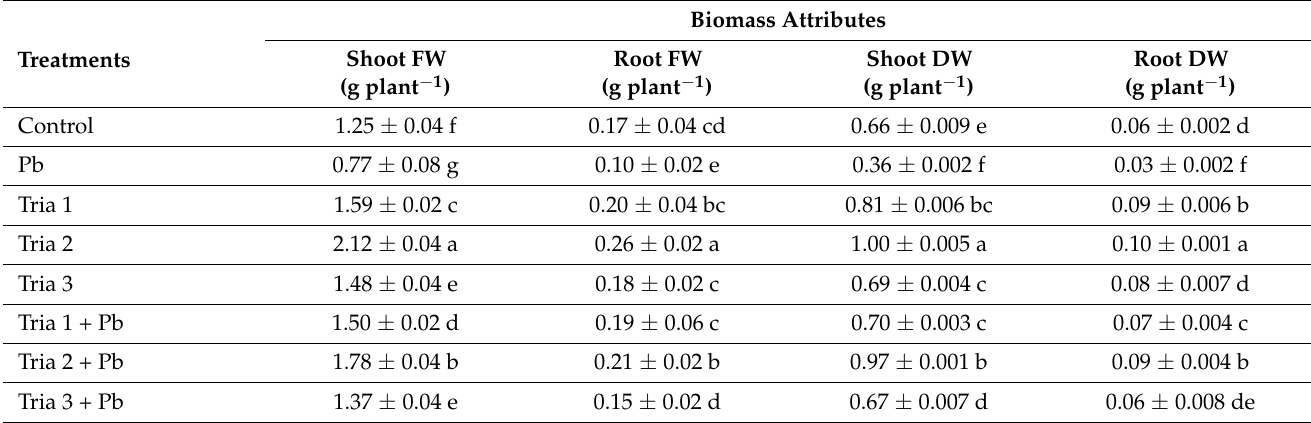
Table 2. Effects of Triacontanol and Pb on Fresh and Dry Biomass of Phaseolus vulgaris L. Seedlings.